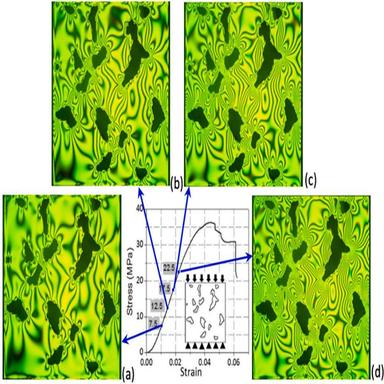
Evolution of plastic concentration zones in the vicinity of pores at different stress levels. The photoelastic fringe pattern when the load is (a) 7.5 MPa, (b) 12.5 MPa, (c) 17.5 MPa, and (d) 22.5 MPa . The copyright permission for this figure has been granted.